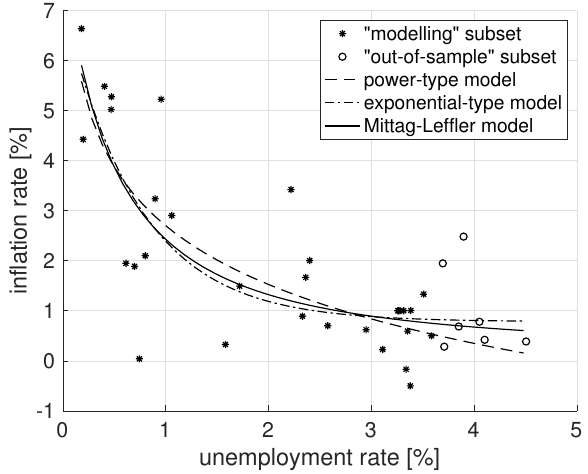
Figure 4. Fitting the Swiss Phillips curve.